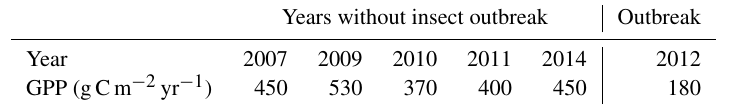
Table 1. Annual GPP derived from the EC tower for the 5 years without insect outbreak and the year 2012 with insect outbreak.